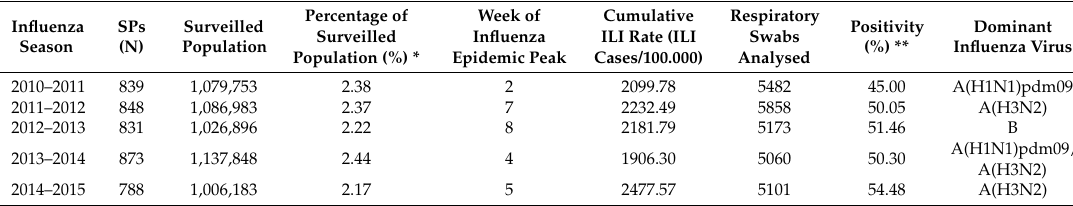
Table 1. Characteristics of the influenza seasons from 2010/2011 to 2014/2015.